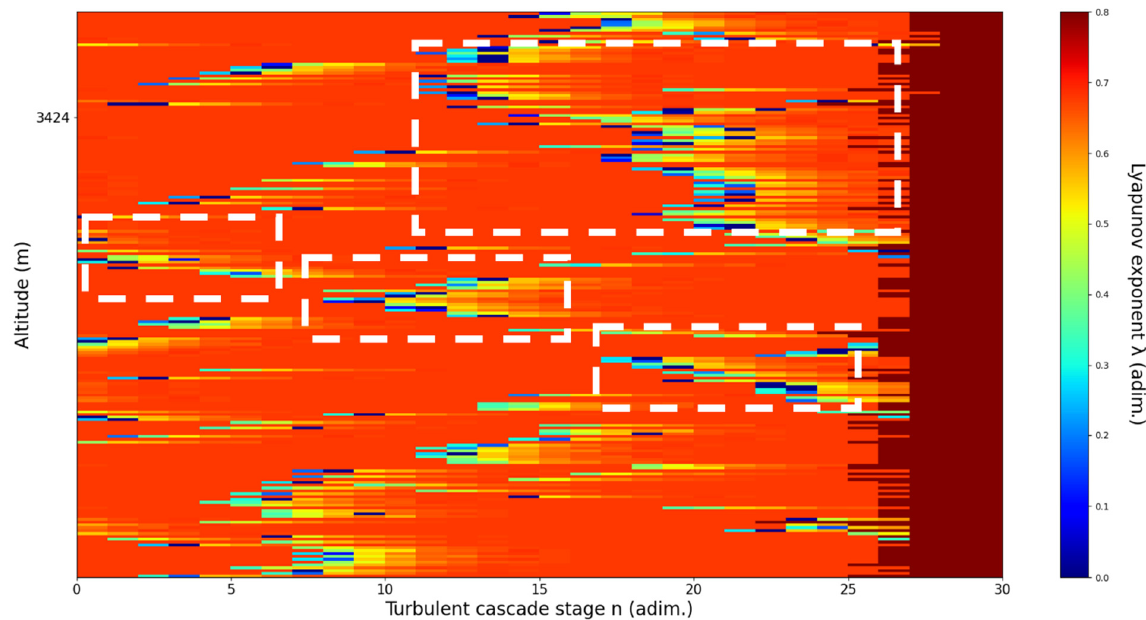
Figure 21. Lyapunov exponent per turbulent cascade stage colormap altitude plot, Bucharest, Romania, 13 June 2019,